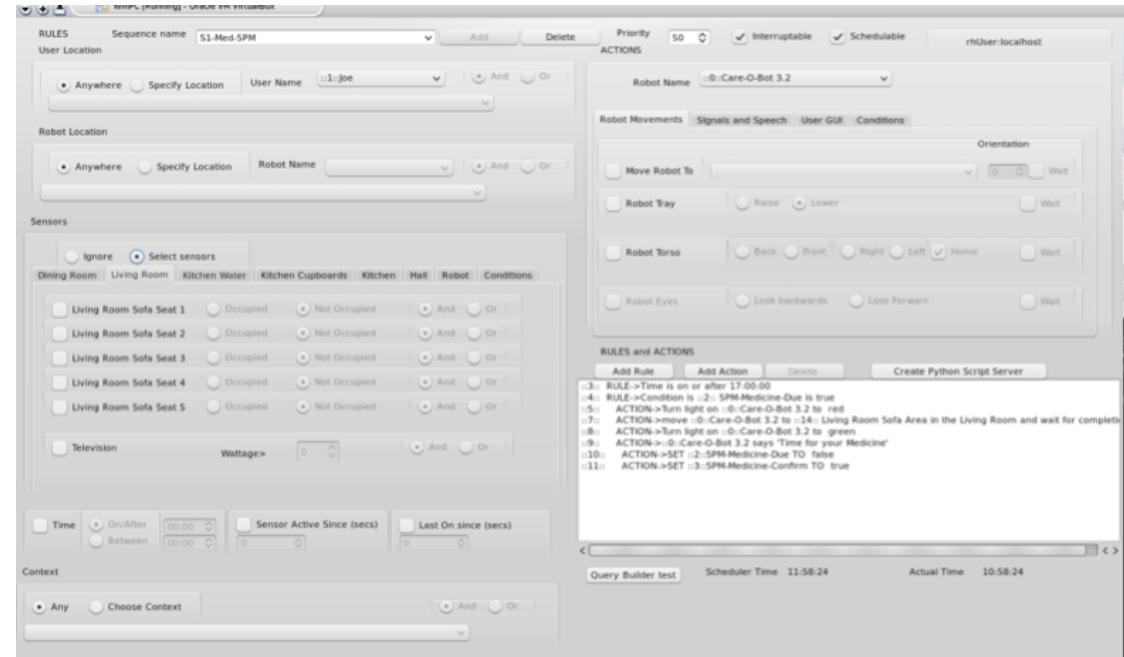
Figure 1. The Sequencer allows behaviour and sequence generation between rule sets based on the robot house ontology and actions to be carried out the robot. Rules can be generated based on user, robot, context, sensors, goals or conditions. Actions on the robot can be physical, sensory (light/speech), virtual (setting new conditions/goals) or user generated via calls to the users tablet computer. The interface also allows direct creation of python programs to control the robot directly.